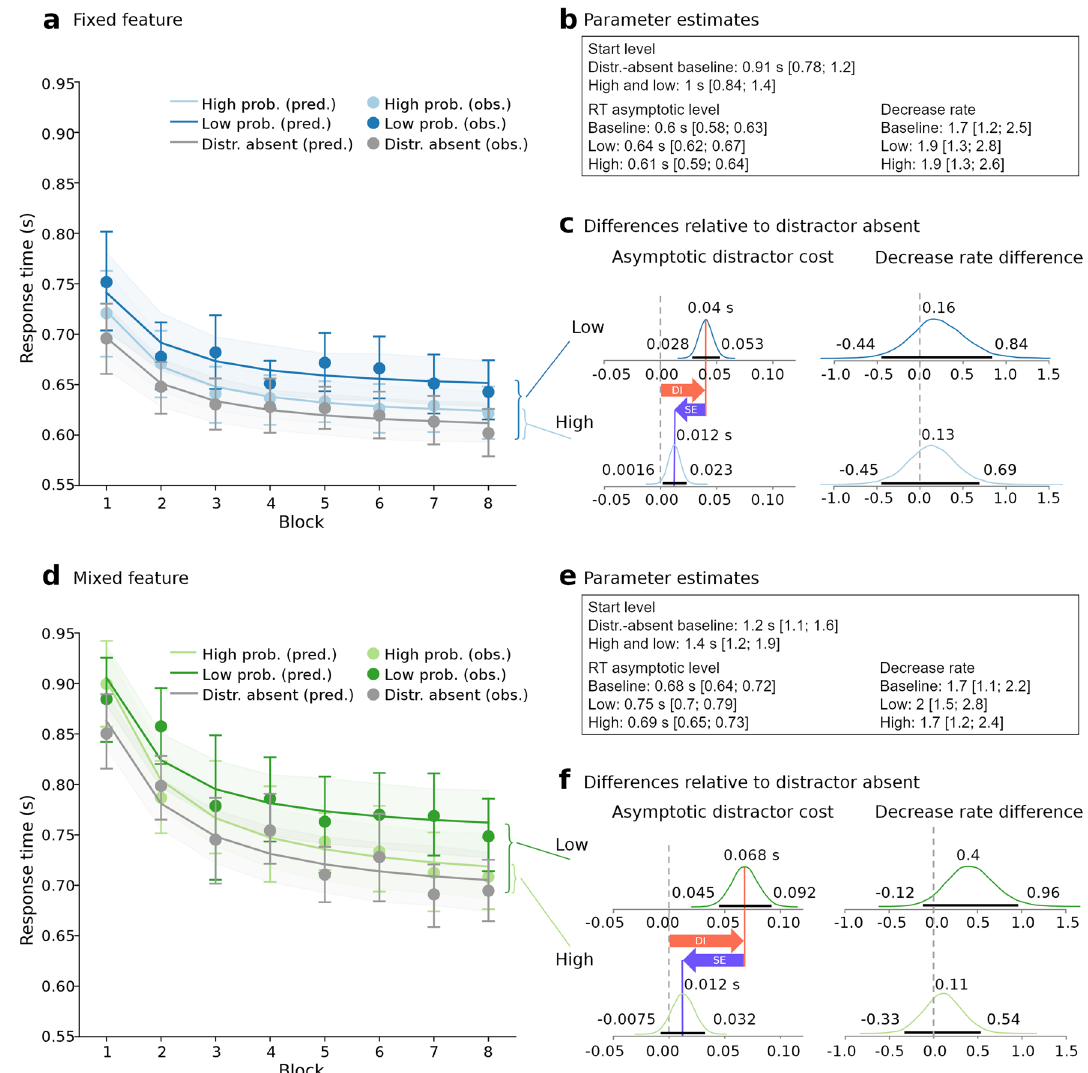
Figure 6. Learning curves across experimental blocks for the fixed-feature task ( a–c ) and mixed-feature task ( d–f ). ( a , d ) Points show the observed response times for the distractor-absent condition (in grey), and low- (dark colours) and high-probability (light colours) locations. Error bars are 95% confidence intervals. Lines visualize the model predictions as the mean of the expected RT of each participant at each level (means of the posterior predictive distributions). The shaded areas depict the 95% confidence intervals of these participant scores. Block 1 is the practice block. ( b , e ) Group-level parameter estimates with 95% Highest Probability Density (HPD) range in square brackets. ( c , f ) Posterior distributions of the asymptotic distractor cost (left panels; low- and high-probability locations in upper and lower rows, respectively) and decrease rate differences to the baseline (right panels). The orange arrows depict the asymptotic distractor interference (DI), the purple arrows depict the asymptotic distractor suppression effects (SE). Horizontal black bars indicate the 95% HPD